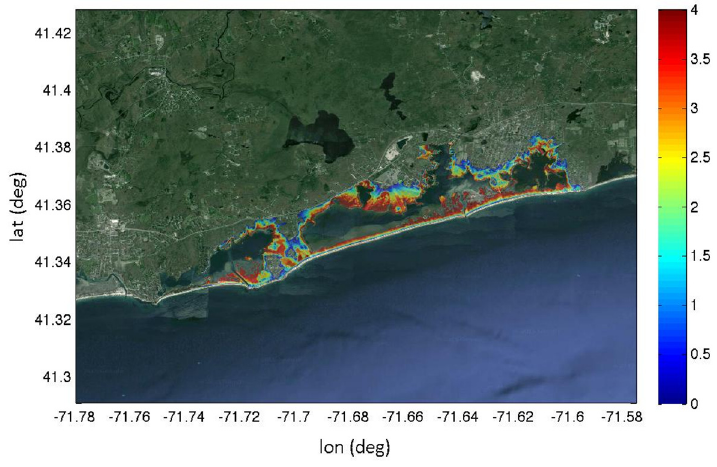
Figure 5. Inundation depths (m) relative to grade for Charlestown, RI for 100 year event.